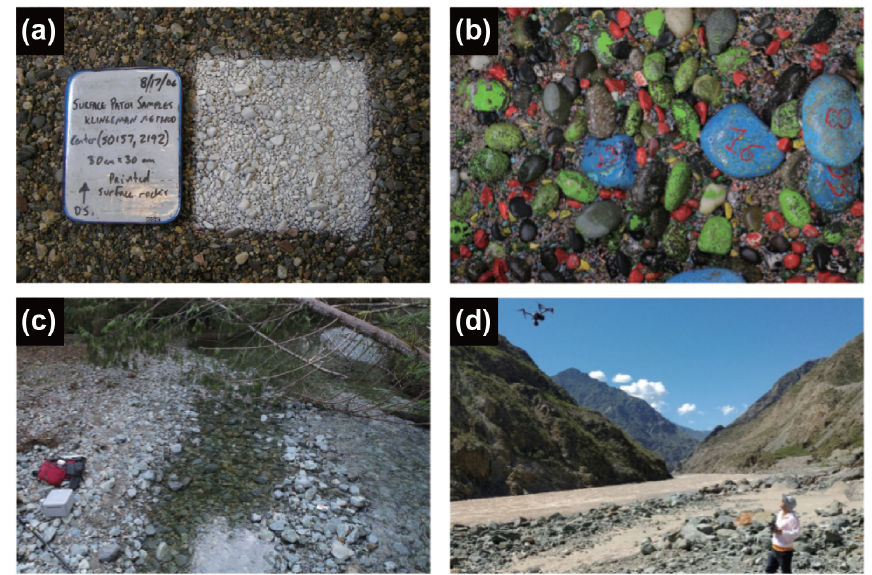
Figure 1. Four typical environments in our datasets: (a) bed sample collected in SAFL; (b) step-pool channel bed in MCHEL; (c) Carnation Creek; and (d) Upper Yangtze